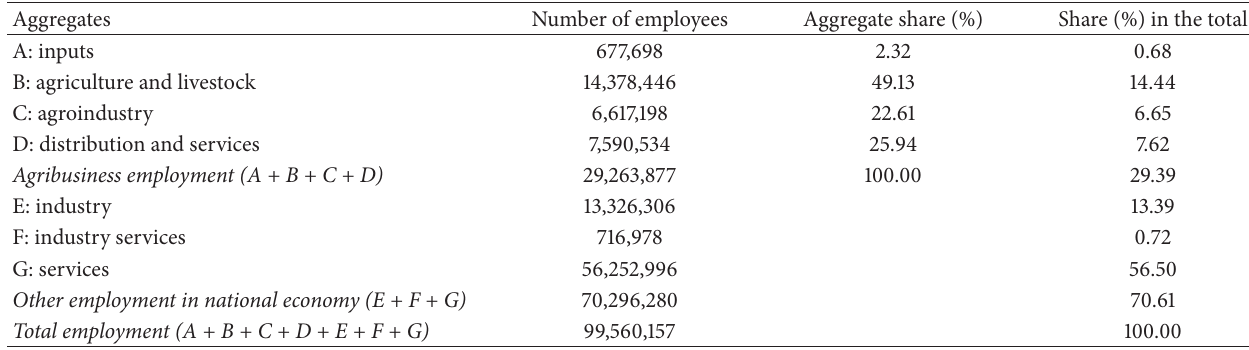
Table 4: Employment in Brazil and agribusiness,